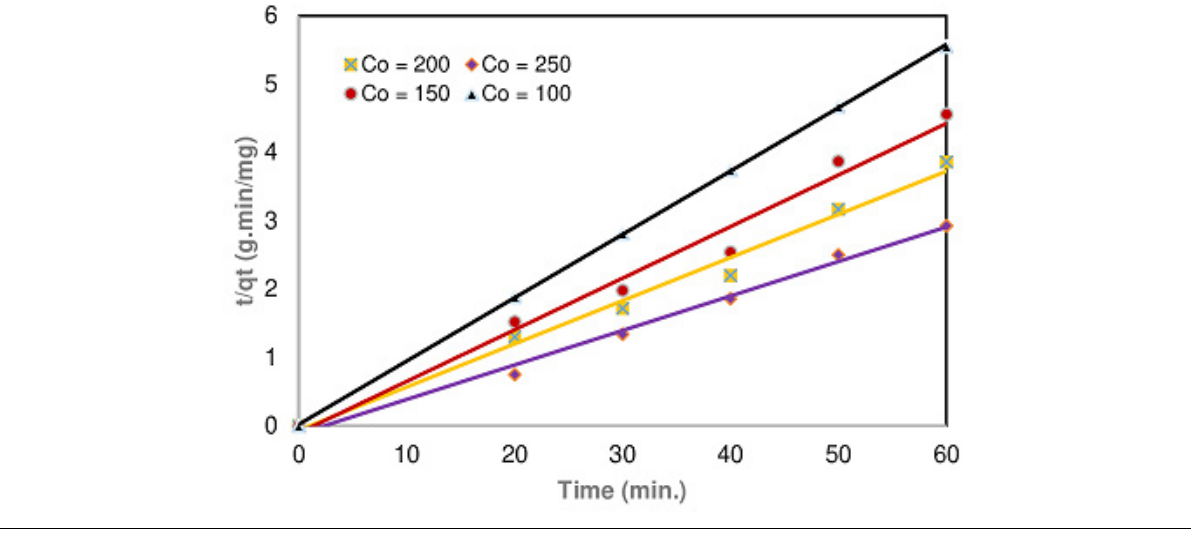
Figure 7: Pseudo-second-order model fitted to batch equilibrium data for edible oil wastewater